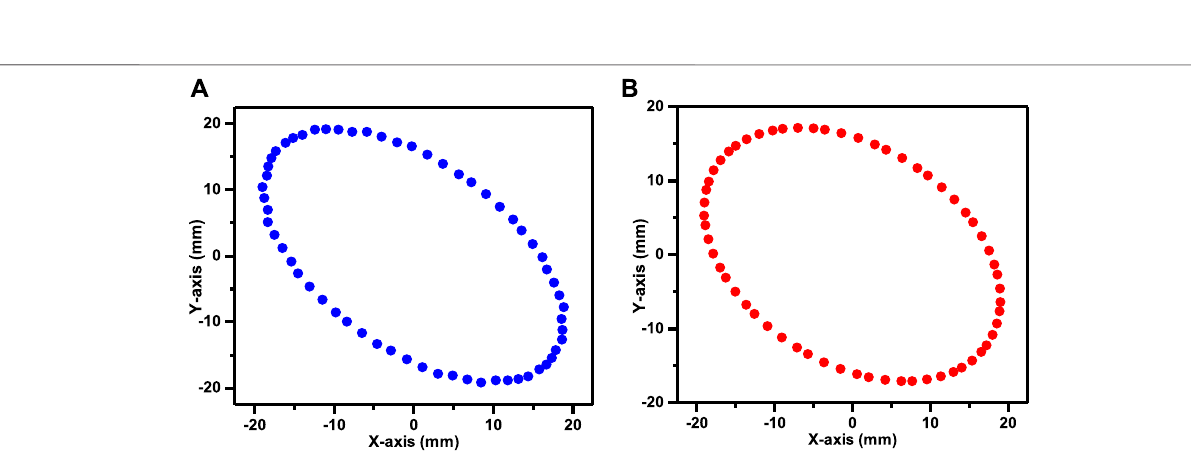
result mainly from the astigmatism of the off-axis spherical mirror M 2 , which plays an important role in the spot pattern evolution caused by the off-axis spherical mirror ’ s astigmatism.